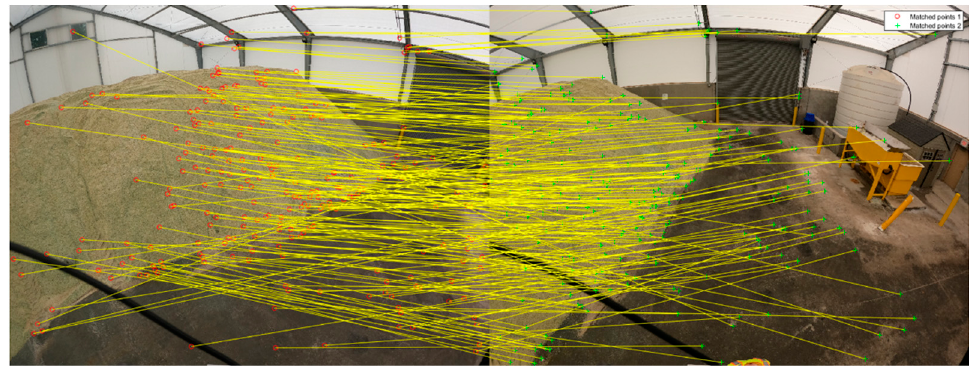
Figure 12. Traditional exhaustive matching strategy: each feature descriptor in the left image is com- pared with all feature descriptors in the right image.